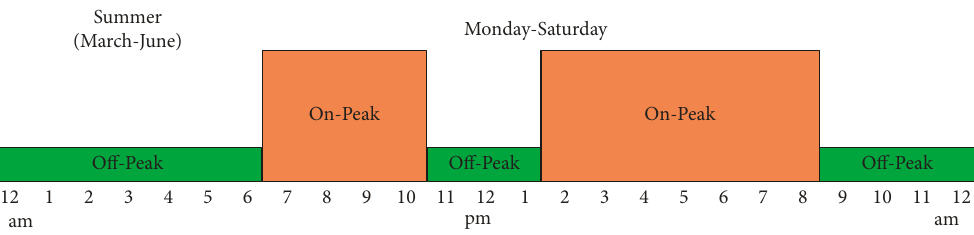
Figure 4: Proposed on-peak and Off-peak hours for summer season.